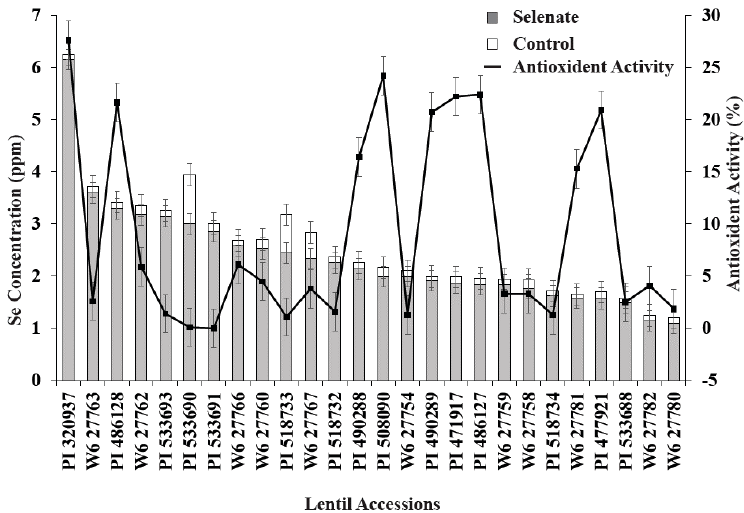
Figure 2. Variation of seedling Se concentration and antioxidant activity for 26 lentil genotypes during germination with added Se fertilizer. Control data are not shown as % inhibition and Se uptake levels were below the detection limit.